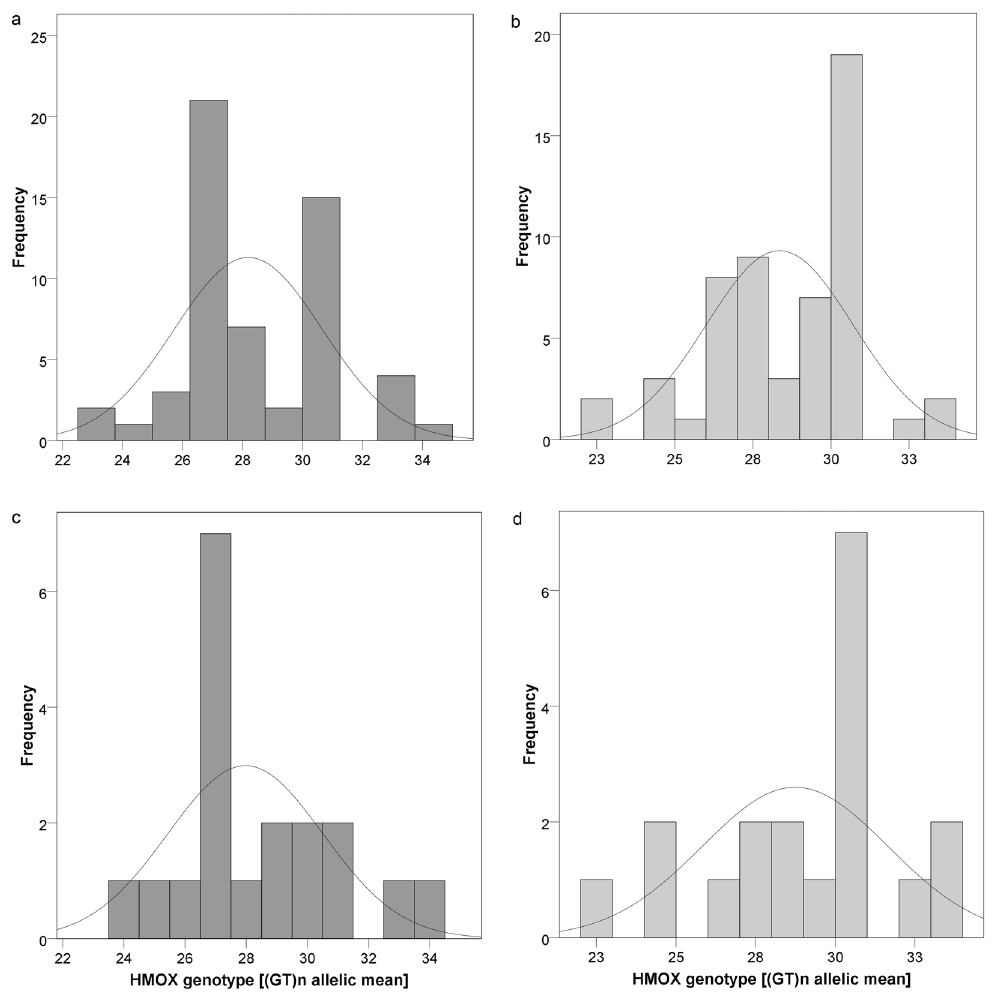
Figure 2. ( a – d ) Histograms showing frequency of HMOX -genotypes (classified as SS, SM, SL, MM, ML) stated in the BiliHealth study population. Figure 2 shows statistical distribution and frequency of respective HMOX - genotypes, expressed as (GT) n allelic mean, between the study groups. ( a and b ) Male and female (all) subjects (Phenotype: GS: dark grey; C: light grey). ( c and d ) Female subjects only (Phenotype: GS: dark grey; C: light grey). Data distribution proposes a non-significant higher abundance of SM alleles in GS individuals, whereas the MM variant appeared to be more prominent in C subjects. This non-significant observation suggests a (gender-specific) higher frequency of shorter GT-repeats in GS individuals, which would be worth pursuing in a larger study collective. Classification of GT-fragment lengths (S < 26, L > 30) was performed following Chang et al . 72